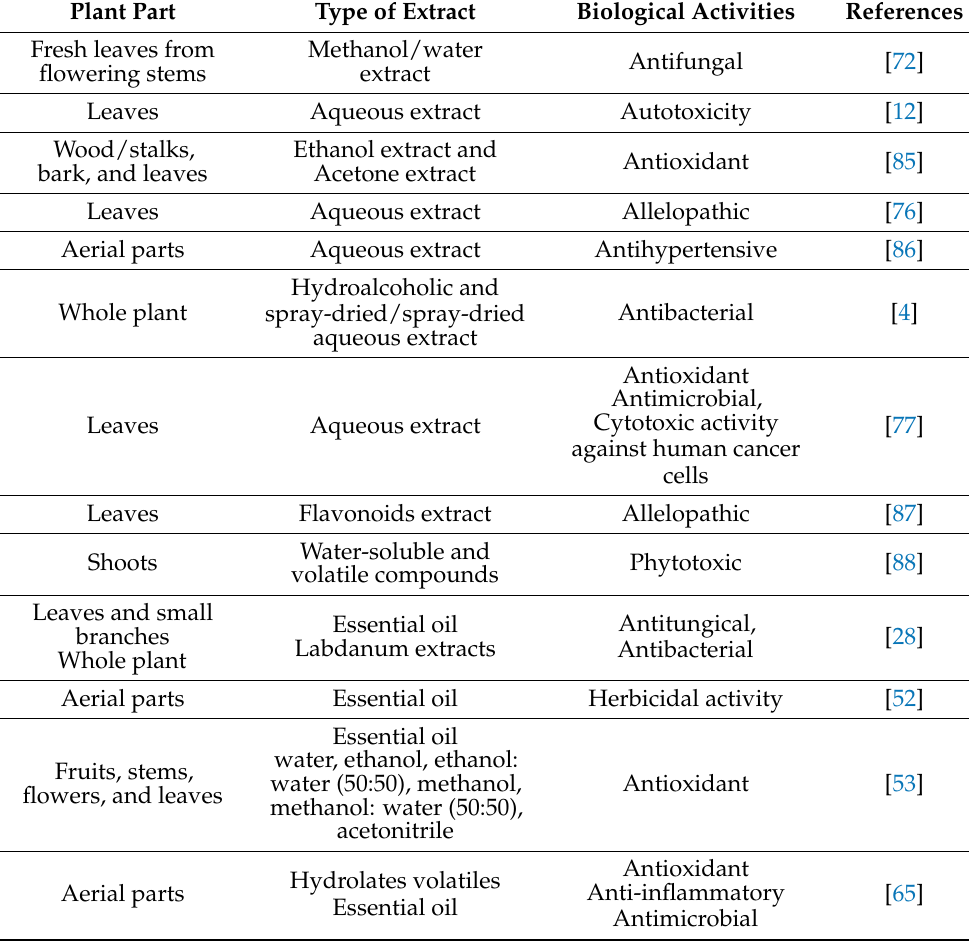
Table 3. Biological activities of C. ladanifer extracts obtained with different solvents from different plant